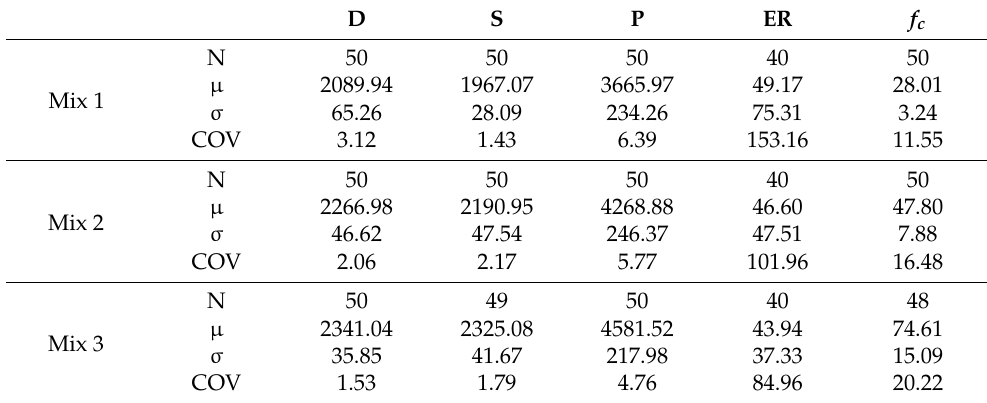
Table 5. Summary of statistical analysis of the